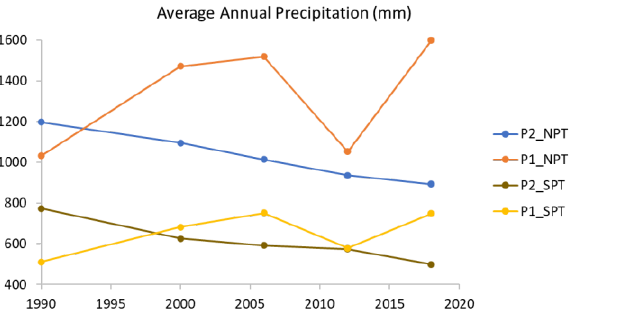
Figure 5. Average annual precipitation (mm) by data source and sectors. P1—WorldClim; P2— SNIRH; NPT—North of Portugal (PTRH1, PTRH2, PTRH3, PTRH4); SPT—South of Portugal (PTRH5, PTRH6, PTRH7, PTRH8).